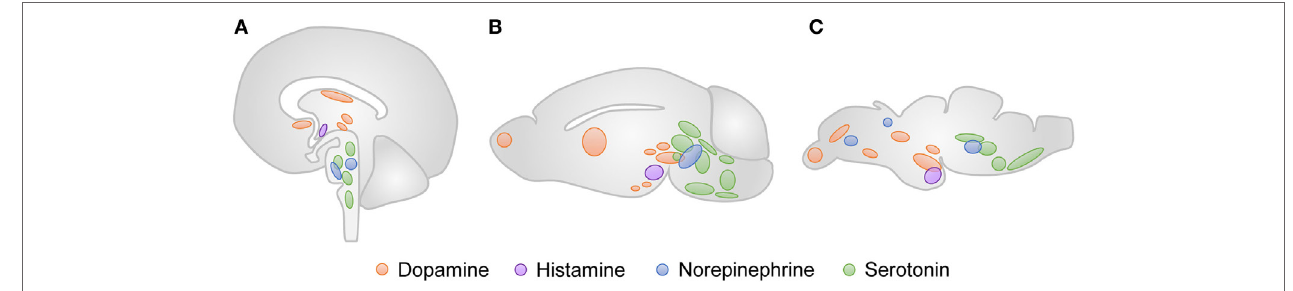
FiguRe 4 | Neuronal clusters that modulate movement in vertebrates. The approximate anatomical location of the dopaminergic (orange), histaminergic (purple), noradrenergic (blue), and serotonergic (green) regions are represented for human (a) , rodent (B) , and zebrafish (c)